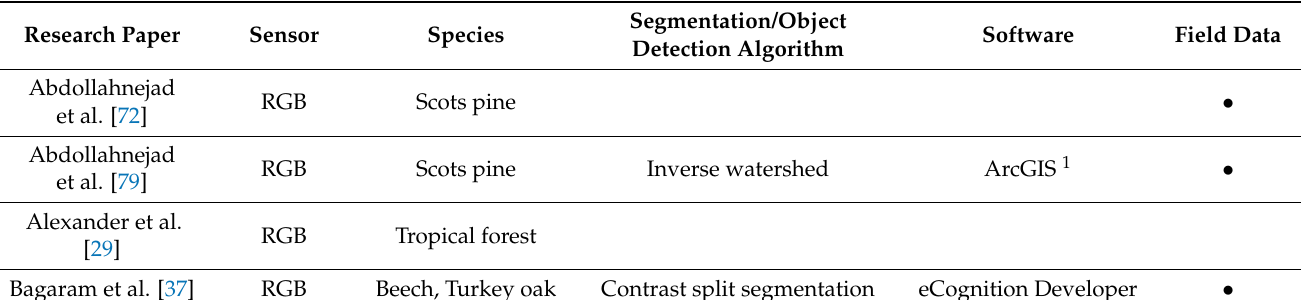
Table 2. Reviewed studies for tree detection and inventory parameters topic: sensor, tree species, segmentation algo- rithm/object detection method, software for object detection, other remote sensing (RS) platforms use/comparison, and field data